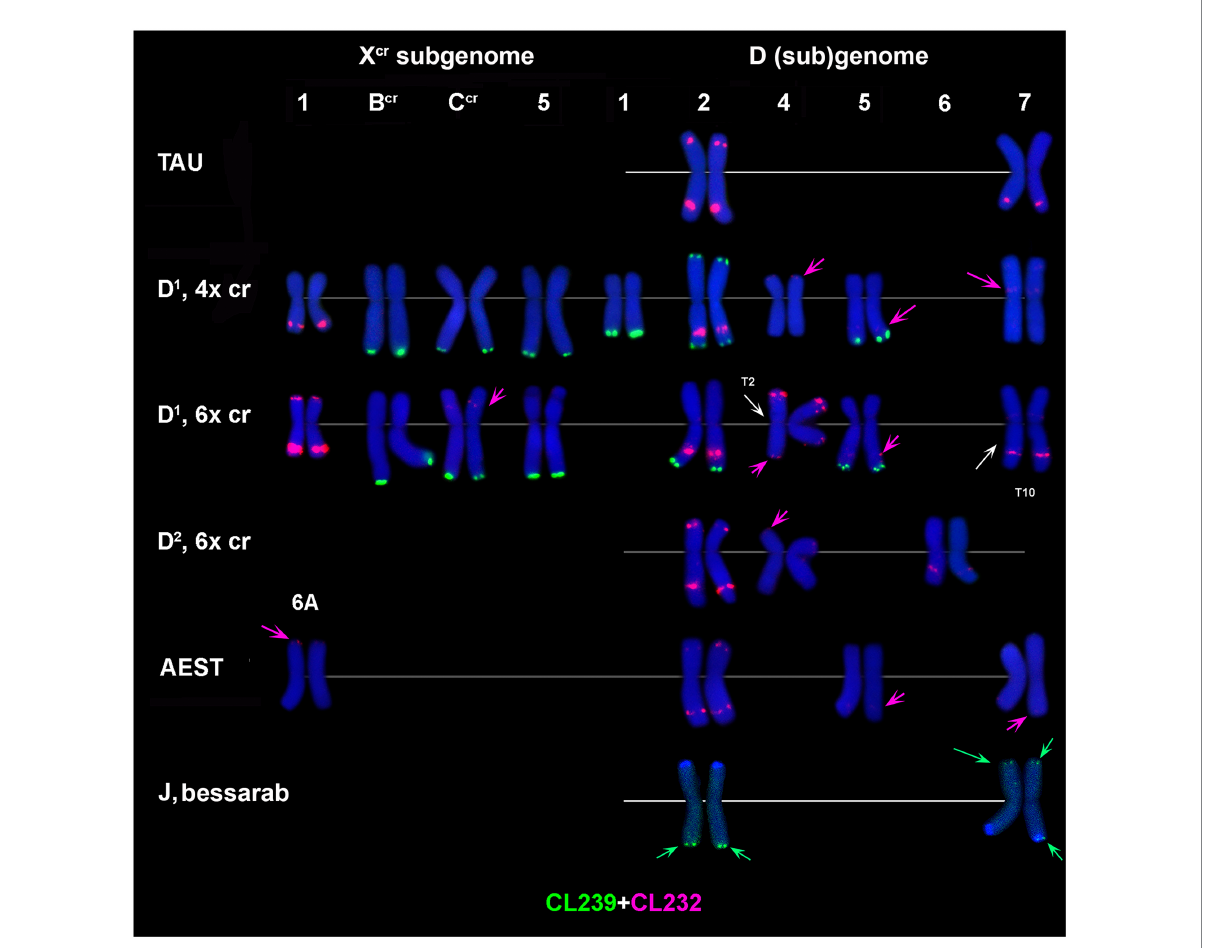
FIGURE 4 Distribution of CL239 (green) and CL232 (red) sequences on chromosomes of different cereal species: TAU – Ae . tauschii ssp. strangulata; D 1 , 4x cr – D 1 subgenome of tetraploid Ae . crassa ; D 1 , 6x cr, D 2 , 6x cr – D 1 and D 2 subgenomes of hexaploid Ae . crassa; AEST – A and D subgenomes of T . aestivum , J, bessarab – J b genome of Th . bessarabicum . 1–7 – homoeologous groups. Pink arrows point to minor CL232